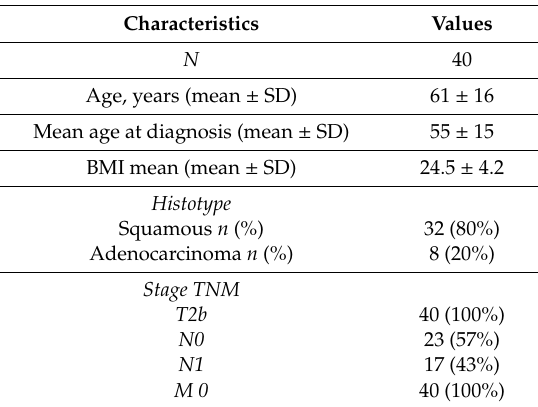
Figure 1. Flow chart of the study. Patient selection from our database of patients with cervical cancer. Table 1. The population’s characteristics.